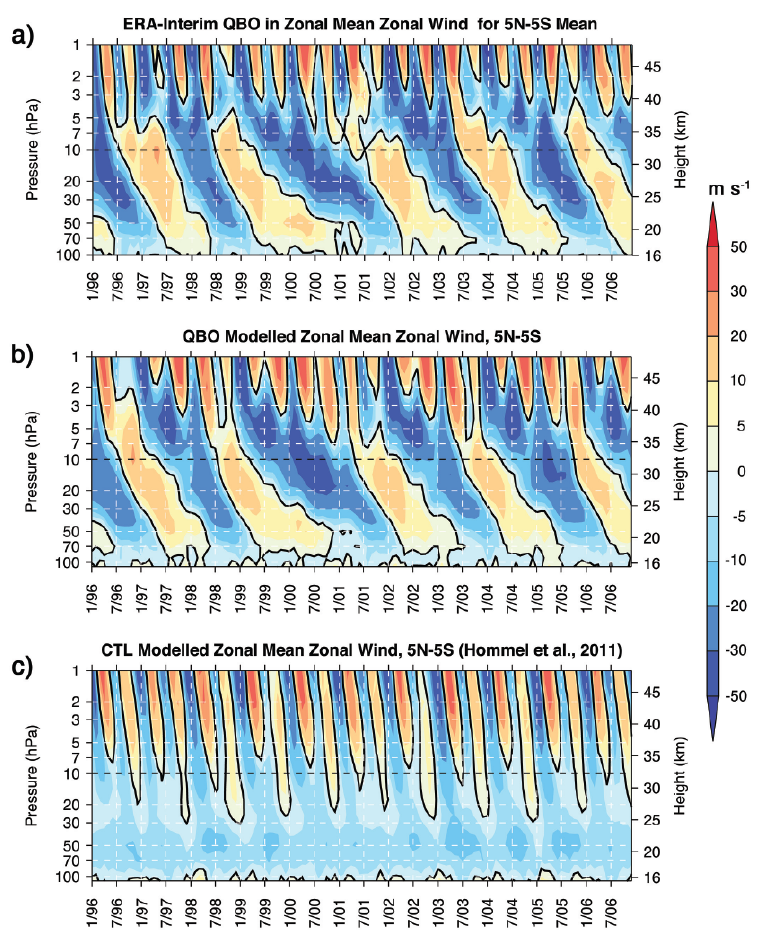
Figure 1. Temporal evolution of the monthly zonal mean zonal wind in the equatorial lower stratosphere between 5 ◦ N and 5 ◦ S for the years 1996–2006 in the (a) ECMWF ERA-Interim reanalysis and MAECHAM5-SAM2 simulations (b) with QBO-nudging and (c) in the control experiment (CTL) of Hommel et al. (2011). Reddish colours represent westerlies, blueish easterlies. Black contours highlights the month and altitude of wind